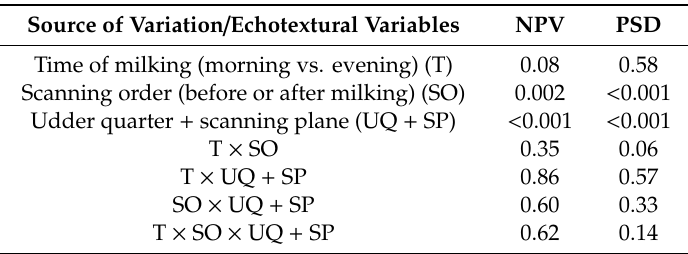
Table 3. General Linear Model Analysis of Variance (ANOVA) table for the echotextural characteristics of mammary gland parenchyma (NPV: Numerical pixel values (0–255) and PSD: Pixel standard deviation or pixel heterogeneity) analyzed with three-way